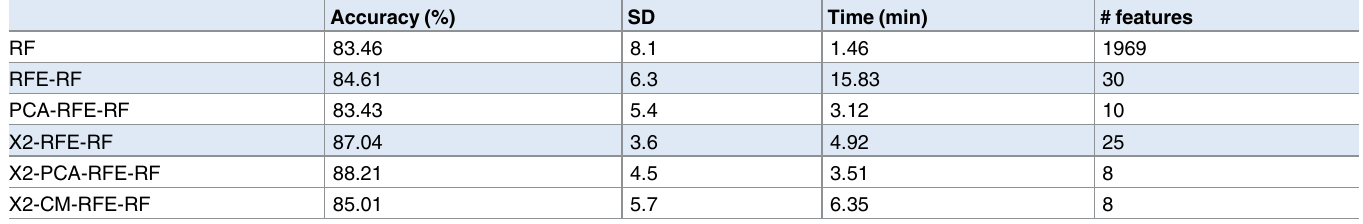
Table 2. Benchmarking of the random forest model (classification) for Dataset1, when different FS methods are applied: (RF) random forest only, (RFE) wrapper recursivefeature elimination with 10-timesinternal cross-validation, (PCA) principal component analysis, (X2) univariate correla- tion filtering or (CM) correlation matrix filter. Each method is applied20 times with randomized and class-balanced trainingdatasets. The accuracy values providedcorrespond to the